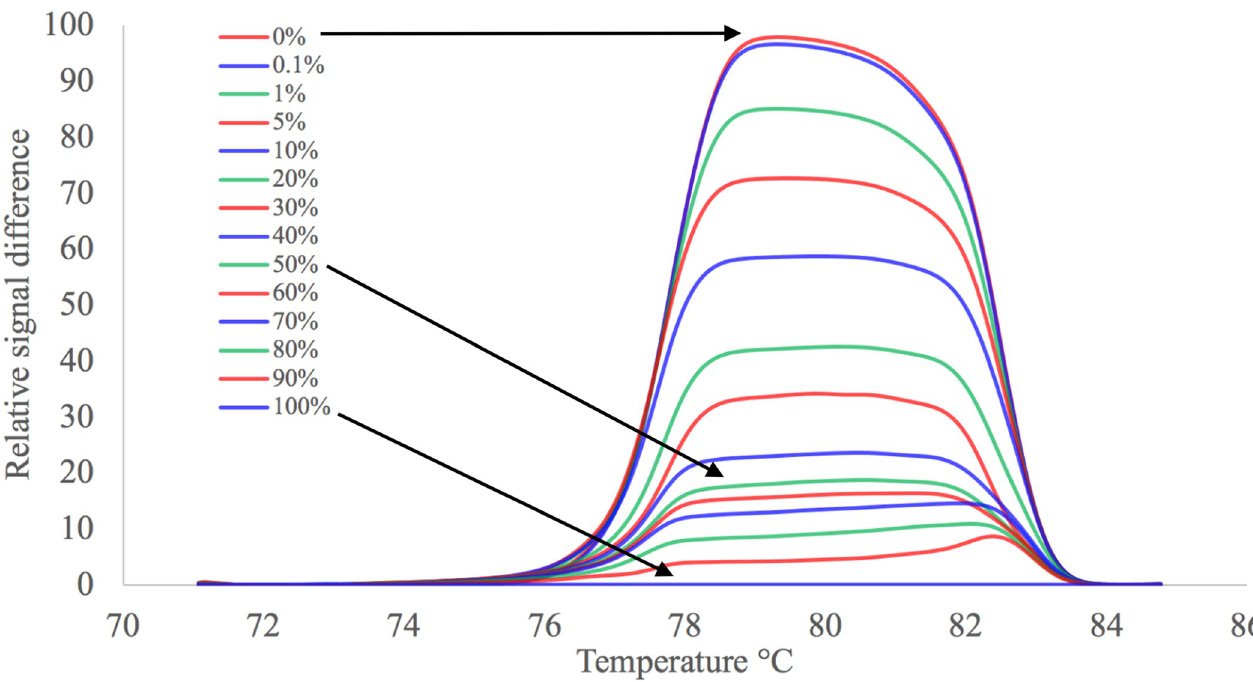
Fig 1. An example of the HRM melting curves transformed into a difference plot with the 100% methylation control used as a baseline for the EpiMelt MGMT assay. Each curve represents melting of the PCR product obtained from the specific mix of the controls (as indicated in the panel) in the range from 0.1 to 90% methylated template in non-methylated background.